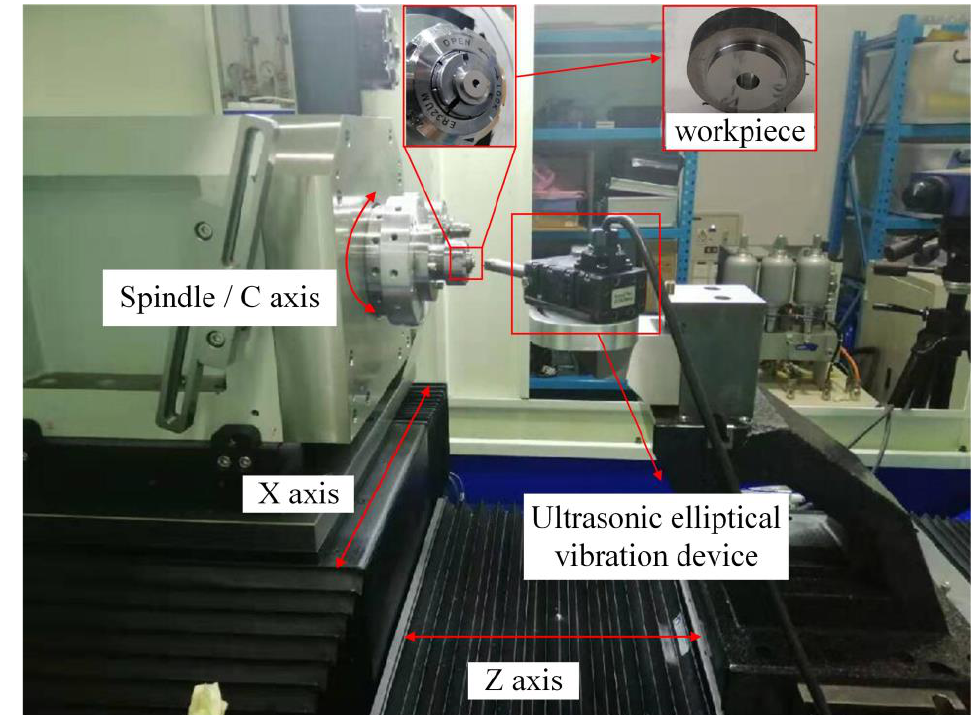
Figure 6. Schematic diagram of cutting device and workpiece.